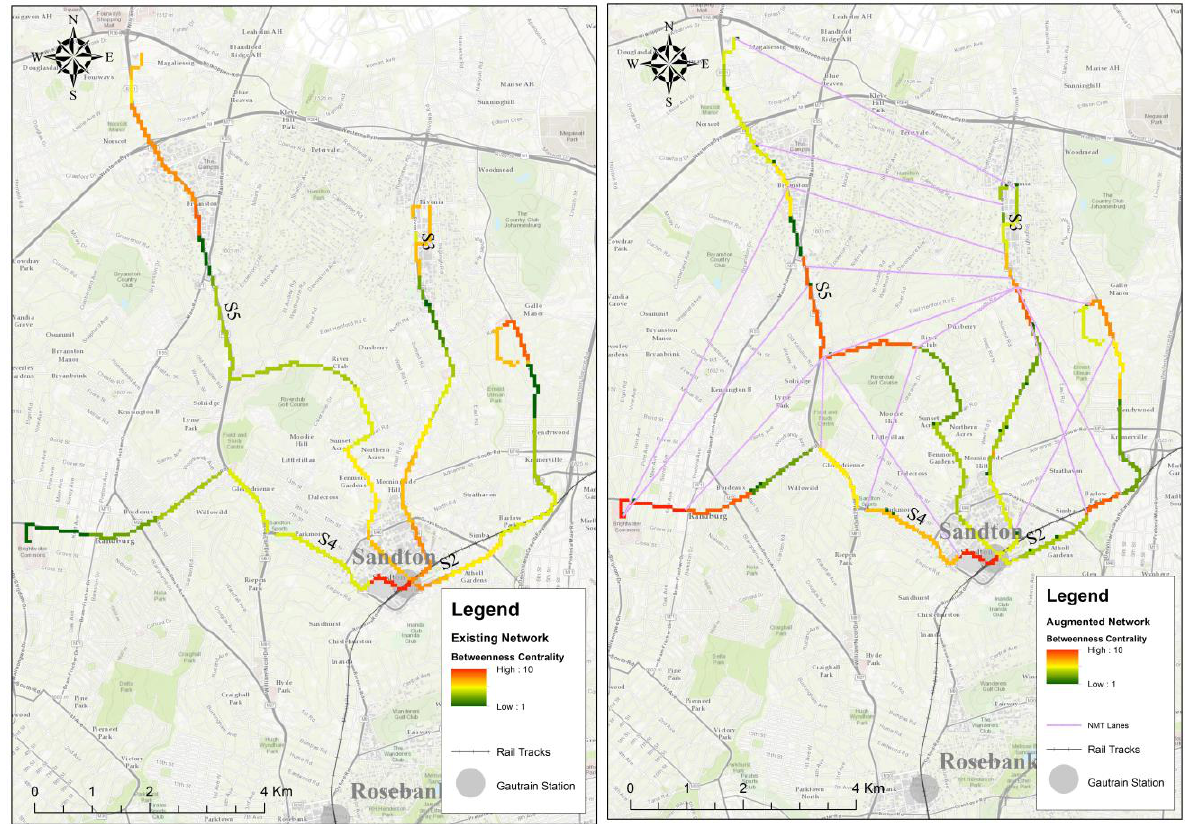
Figure 5: Betweenness centrality of Existing and Augmented Gaubus